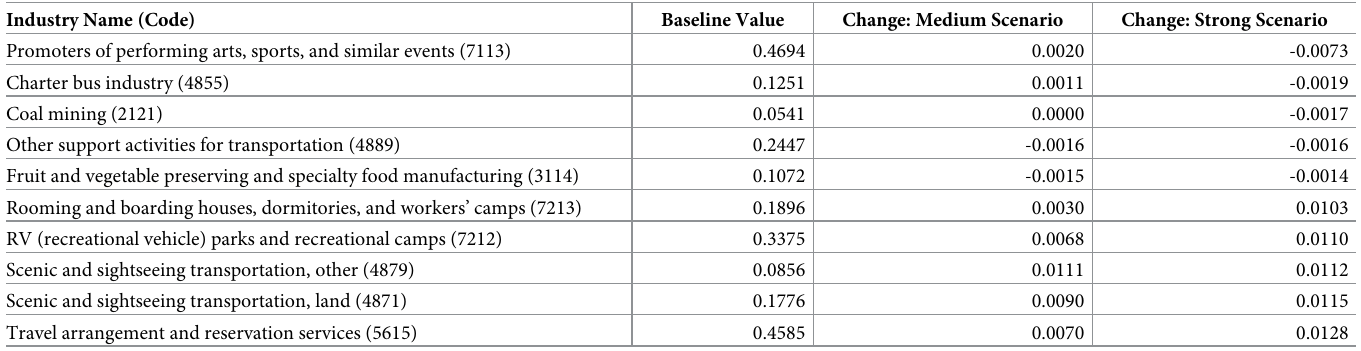
Table 13. Projected changes in fraction of jobs that can be performed remotely by 4-digit industry.